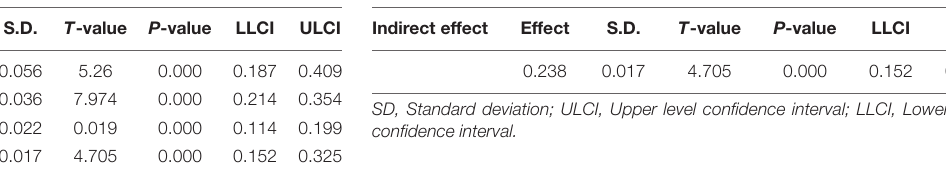
TABLE 5 | Hypothesis testing.